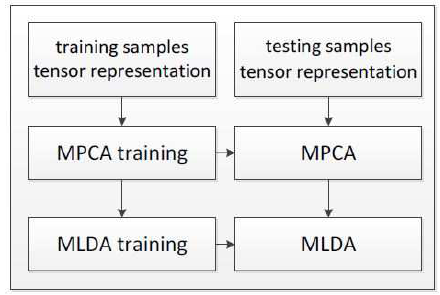
Figure 1. Algorithm flow chart of the subtensor extracting with the proposed